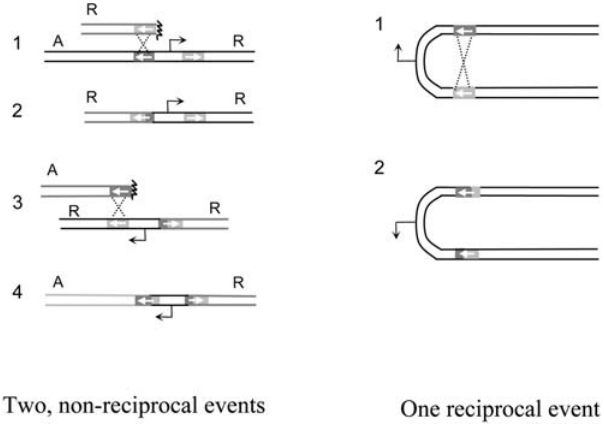
Figure 3. Generation of an inversion between the oxa sequences. Left panel: two successive, non reciprocal events: Oxa sequences are shown with oriented boxes, dark and light gray. Step 1, a broken piece containing the rightward copy of oxa recombines with intact DNA, and generates an unviable molecule (step2), which in turn recombines its leftward oxa copy with another oxa sequence (step 3). This other broken piece eventually, but not necessarily, consists of the rest of the broken piece shown in step 1. Recombination gives rise to a viable product where the intermediate sequences have been inverted, and the two oxa genes are hybrids (step 4). A and R designate the leftmost and righmost genes of l . Right panel: one reciprocal event. A crossing over is initiated intra-molecularly between the oxa sequences (step 1), and gives rise to the inverted configuration (step 2).